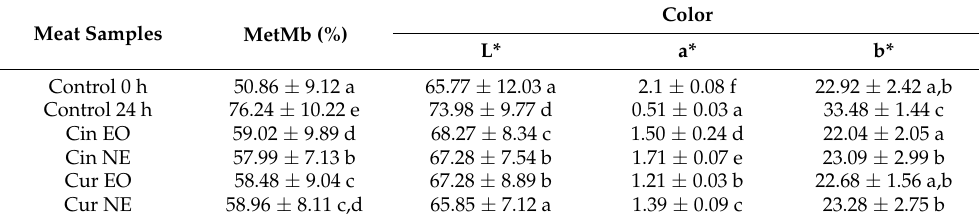
Table 5. Color and metmyoglobin (MetMb, expressed as %) assessments of the control (t = 0 and t = 24 h) and minced meat treated with cinnamon EO, cinnamon NE, curcuma EO, and curcuma NE for 24